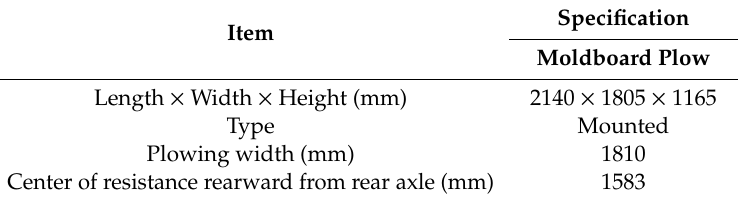
Table 3. Specification of equipment used for plowing [13].